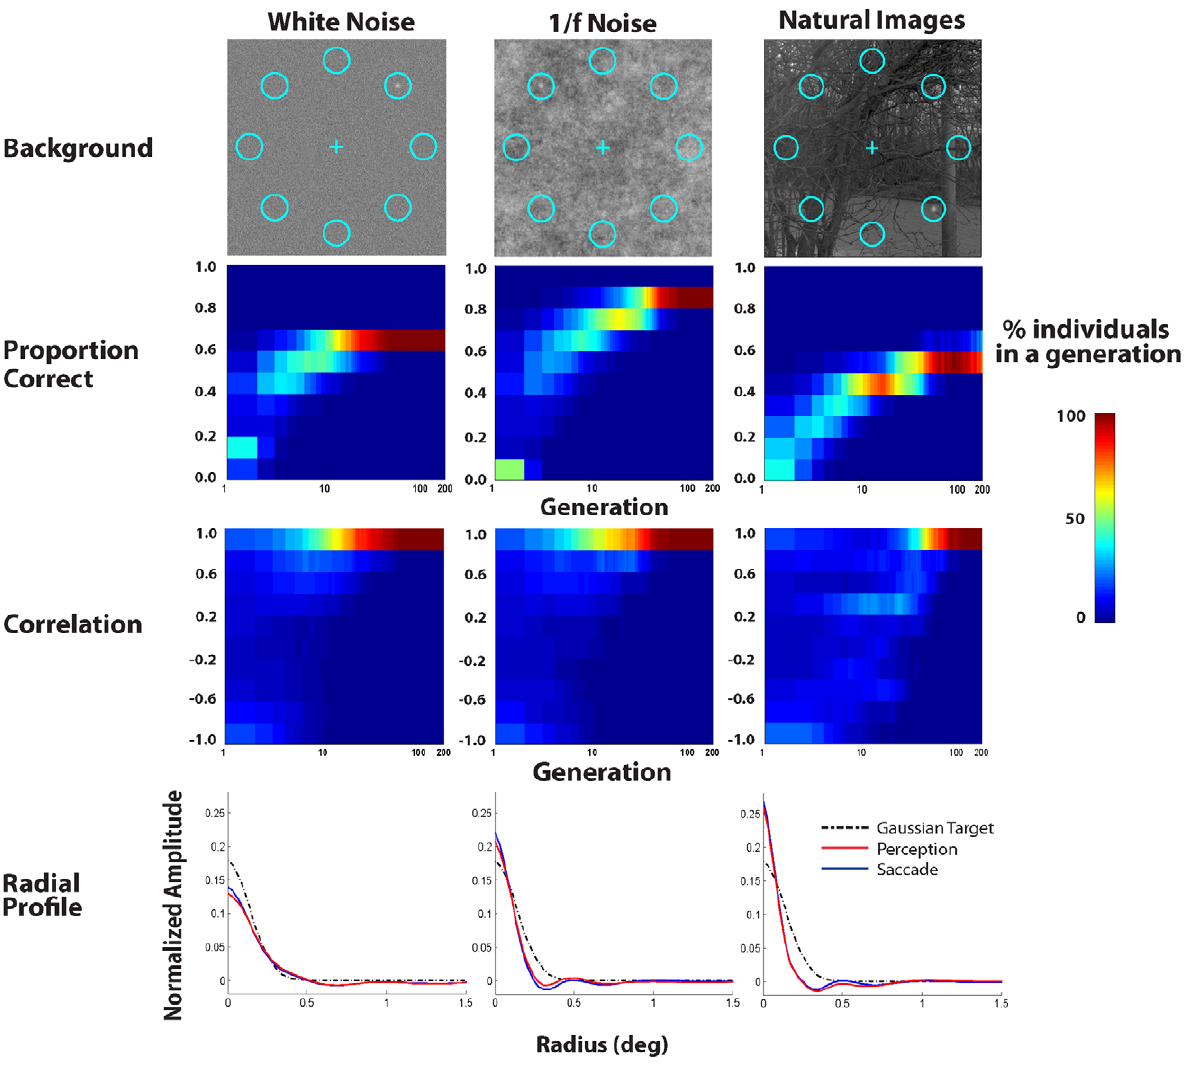
Figure 3. Evolution plots for detecting the isotropic Gaussian target embedded in three different backgrounds. 1 st row: Sample images for the 8 alternative forced choice (AFC) search task for an isotropic Gaussian shaped luminance target with a steep visibility map (Figure 1c left) added to white noise, 1/f noise, and natural images. Center of circles indicate the possible target locations and the central cross is the initial fixation position for the models. 2 nd row: Distribution of search accuracies for simulated individuals as a function of generation. 3 rd row: Distribution of correlations between perception and saccade templates of individuals in each generation. Bottom row: Perception (red) and saccade (blue) templates radial profiles (averaged across all angles) of best performing simulated individual for each background type. Results are averages across ten different virtual evolution runs each with 500 generations. Plots only show data up to the 200 th generation for which convergence has occurred. Radial profile of the Gaussian signal is shown in a dashed line for comparison.